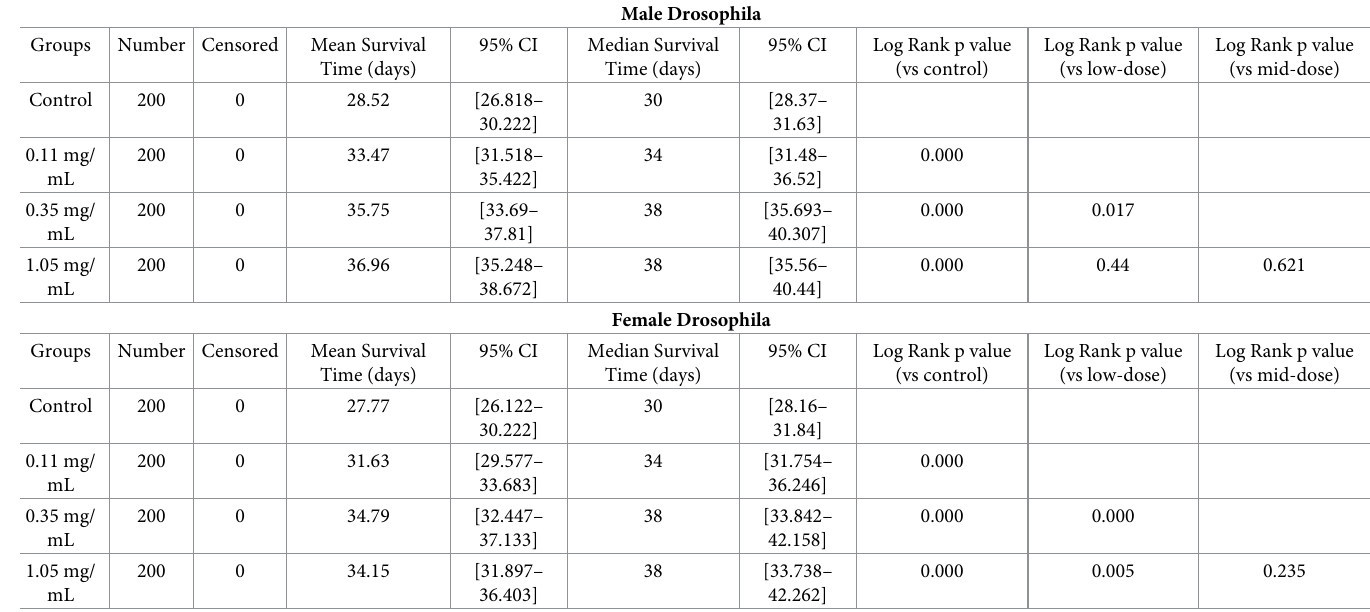
Table 1. Statistical analysis of mean and median survival time in male and female Drosophila after exposure to erinacine A-enriched H . erinaceus